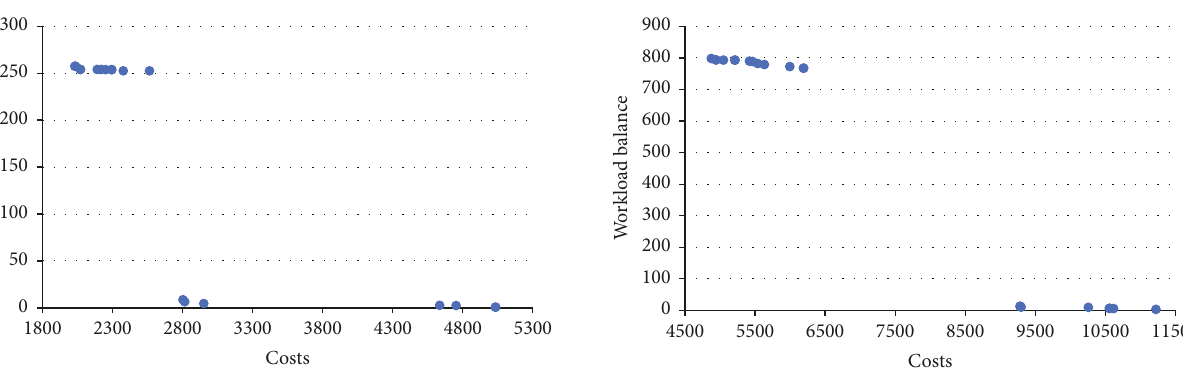
Figure 10: Approximation of the Pareto front of Instance 9.